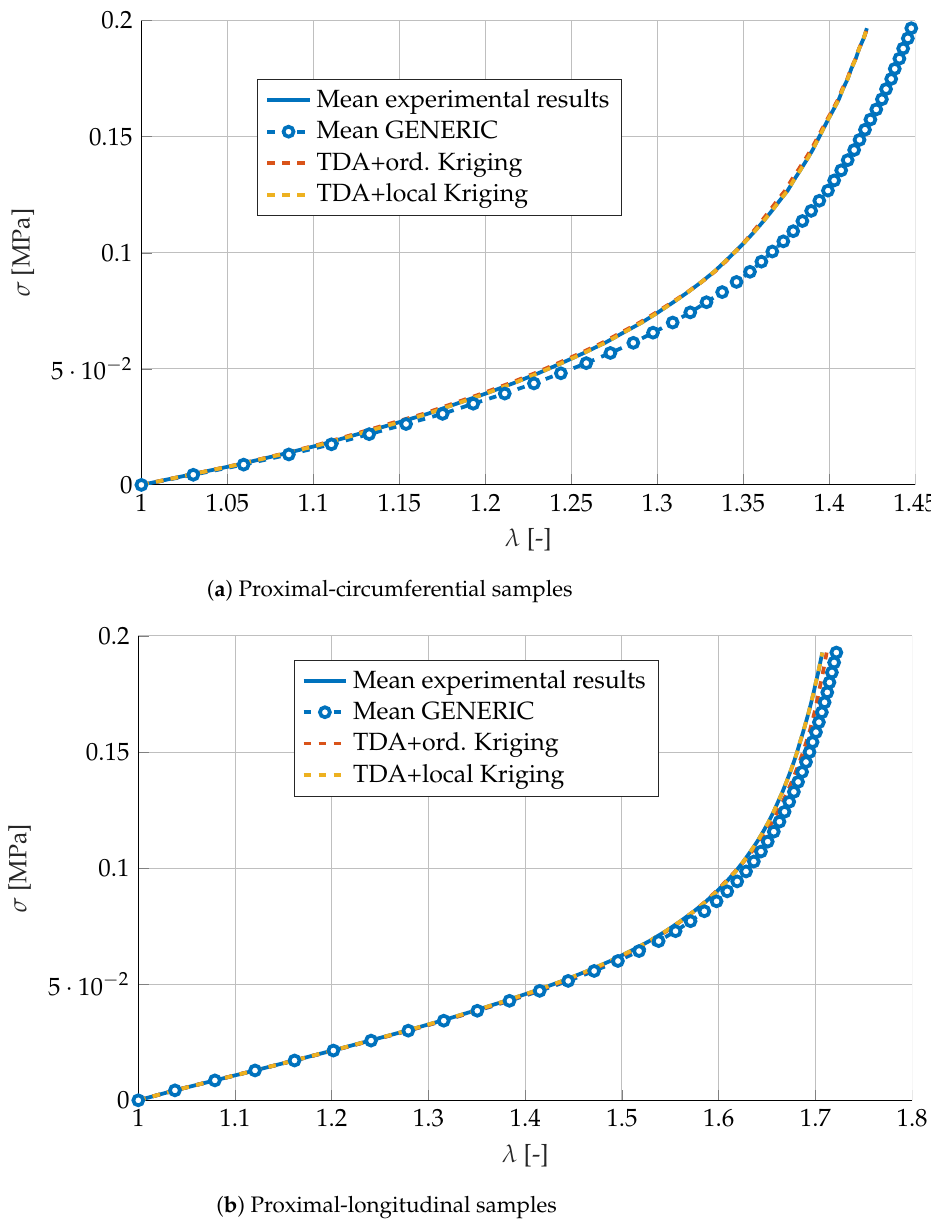
Figure 8. Comparison of ( a ) proximal-circumferential and ( b ) proximal-longitudinal models predicted by mean GENERIC values, or by Kriging interpolation of those samples neighboring the reference solution.